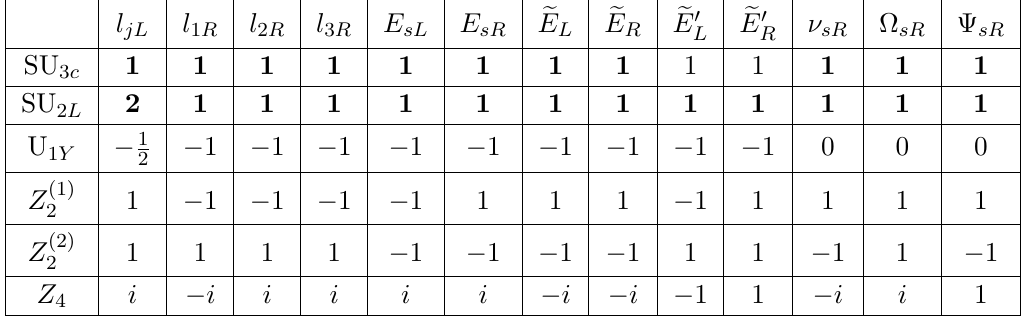
Table 2 . Lepton assignments under SU 3 c × SU 2 L × U 1 Y × Z (1) s = 1 , 2 .